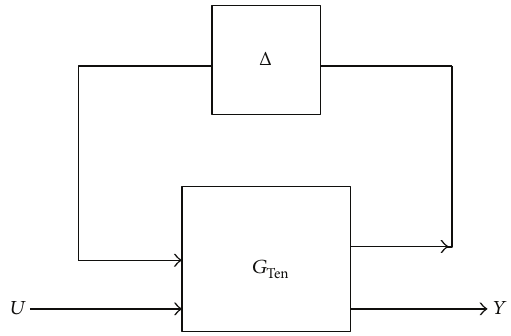
Figure 5: LFT representation of the tension system with uncertain- ties.